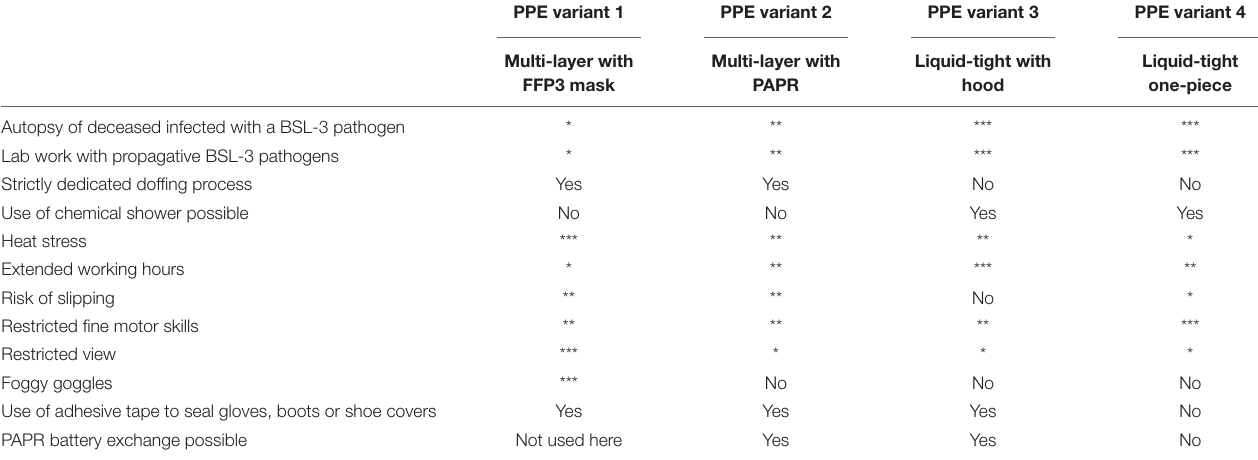
TABLE 3B | The four different personal protective equipment (PPE) variants offer different levels of safety, usability, and personal